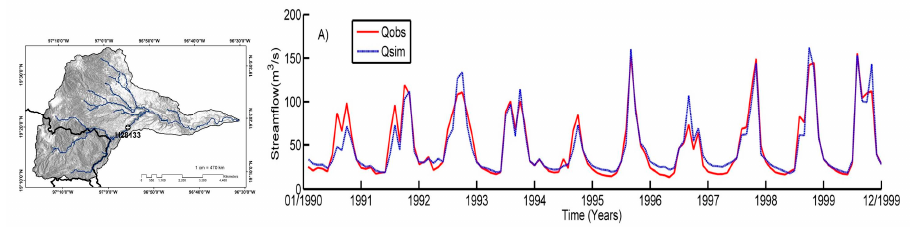
Figure 4. Cont. Figure 4.